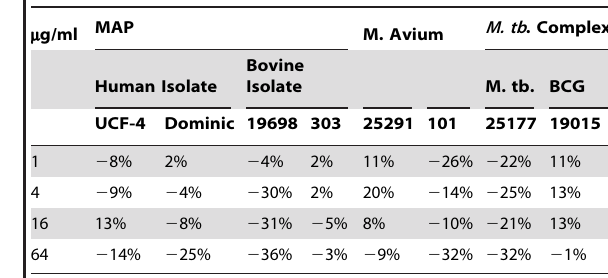
doi:10.1371/journal.pone.0029631.t007 Table 8. Retinyl